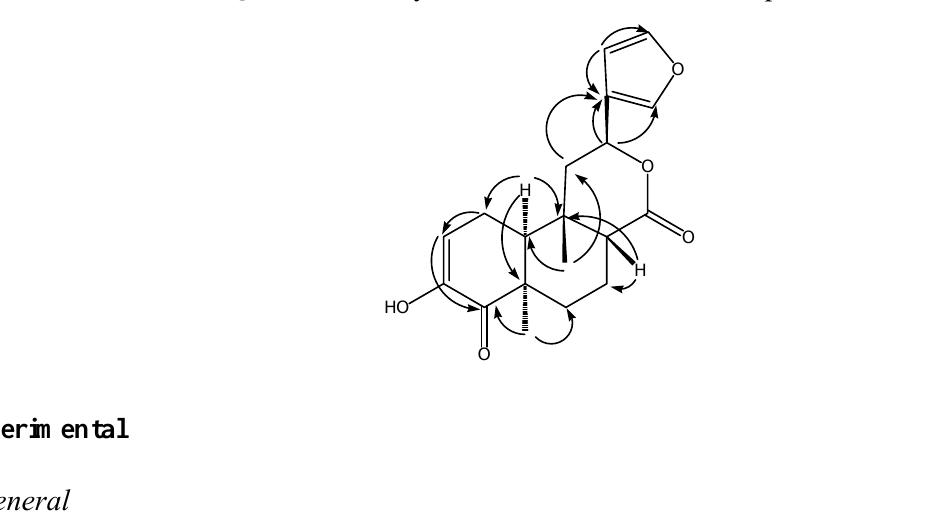
Figure 2. The key HMBC correlations of compound 1